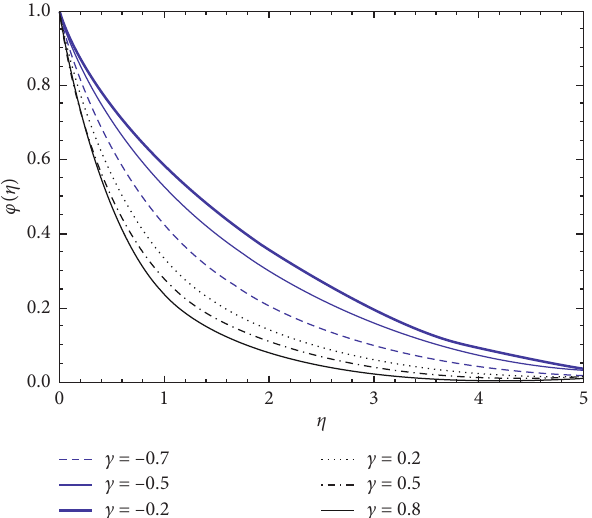
Figure 8: Effects of chemical reaction parameter c on concen- tration